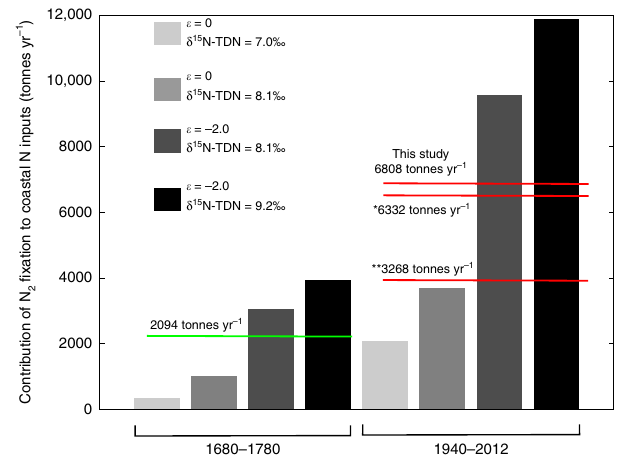
Fig. 4 N 2 fi xation (tonnes N yr − 1 ) contribution to the inshore GBR. Four scenarios are presented for each time period, these re fl ect variability in the isotopic fractionation of N during assimilation into coral skeletons (given as ε , which is known to vary between 0 ‰ and − 2 ‰ 68 ), and the δ 15 N-TDN calculated for terrestrial N (8.1 ± 1.1 ‰ ). The four scenarios are the low and high extremes of N 2 fi xation (i.e. ε = 0 ‰ / δ 15 N-TDN = 7 ‰ , and ε = − 2 ‰ / δ 15 N-TDN = 9.2 ‰ , respectively), and N fi xation resulting from ε = 0 ‰ / 2 δ 15 N-TDN = 8.1 ‰ , and ε = − 2 ‰ / δ 15 N-TDN = 8.1 ‰ (where 8.1 ‰ is the average δ 15 N-TDN calculated for terrestrial N). The green line is the average of the pre-European period and the red lines are values for the modern GBR. The * value is from Messer, Brown et al. 31 , and the ** value is the average of Bell, Elmetri et al. 58 and Furnas, Alongi et al. 26